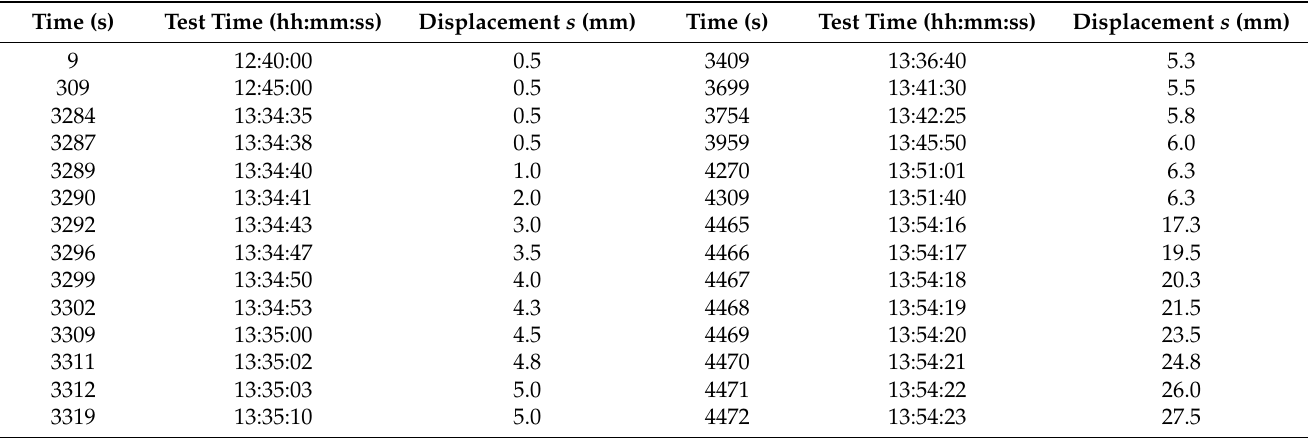
Table A3. Displacements of the cohesive central core tested in